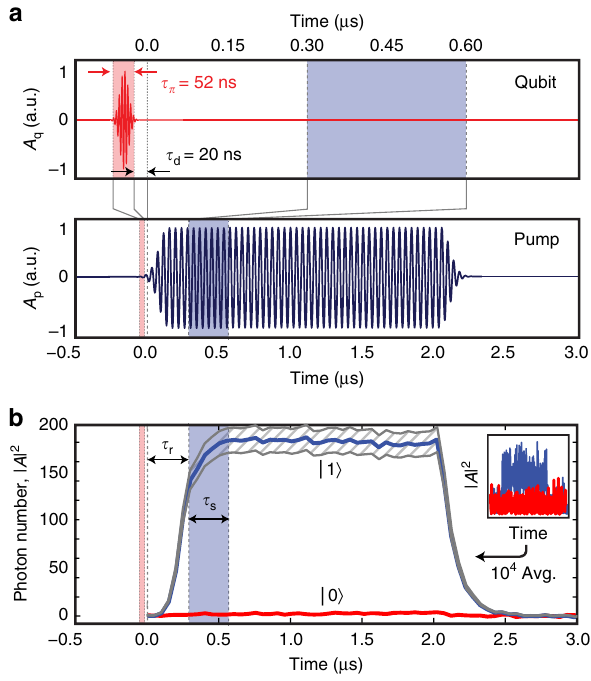
Figure 3 | Qubit read-out by the Josephson parametric oscillator. ( a ) Pulse sequence: the qubit p -pulse (in red), with Gaussian edges and a plateau of duration t p ¼ 52ns, is followed by a short delay, t d ¼ 20ns, before the pump is turned on at time t ¼ 0. ( b ) The solid blue and red traces show the inferred photon number, | A | 2 , in the resonator, with and without a prior p -pulse on the qubit, respectively. Note that the resonator latches, once it has entered into the oscillating state, and remains there even if the qubit relaxes. The traces are the result of 10 4 averages of the raw data; the inset shows a single instance of the raw data on the same time axis as the main plot. Before the sampling window of width t s ¼ 300ns, a delay t r ¼ 300ns is added to avoid recording the transient oscillator response. The hatched region around the average photon number represents our